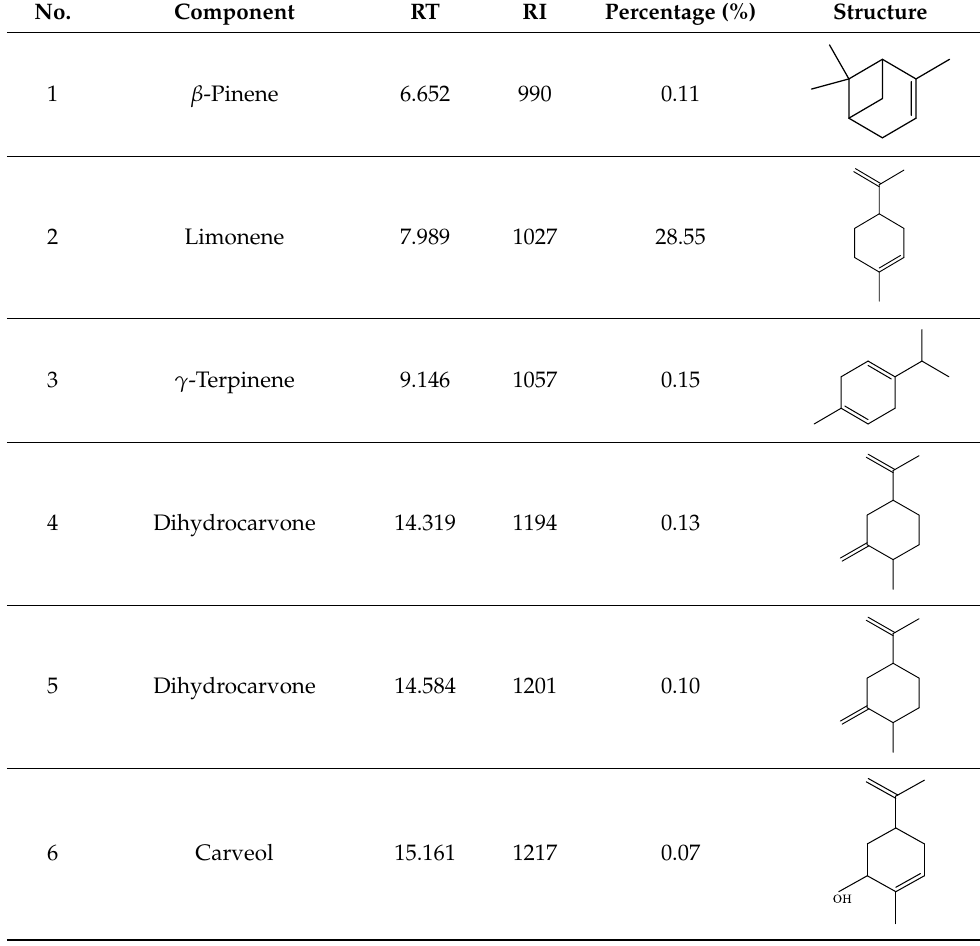
Table 1. The main component of Table 1. The main component of CEO. Table 1. The main component of CEO. Table 1. The main component of CEO. Table 1. The main component of CEO. Table 1. The main component of CEO. Table 1. The main component of CEO.